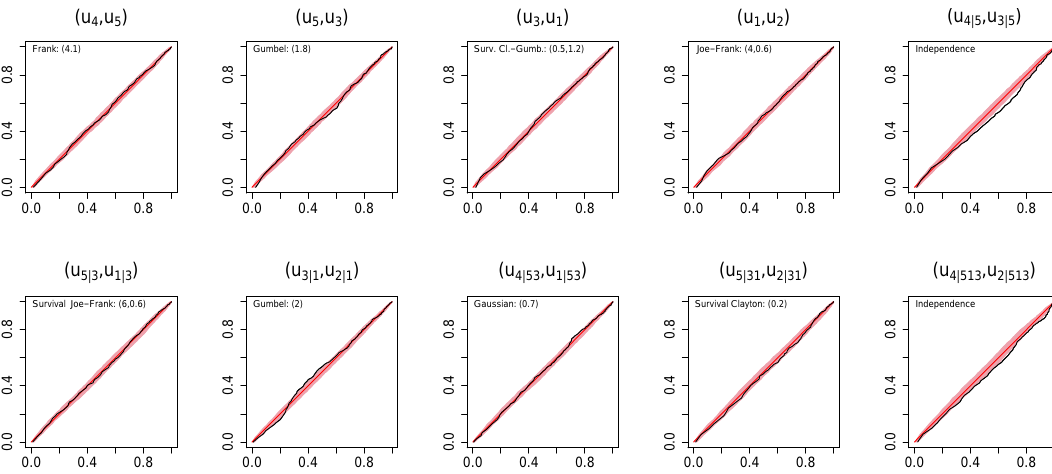
Figure C1. K-plots of the pair-copula families selected for the five-dimensional model (names of the families and parameters are shown in the top left of each plot). In abscissa the empirical K-function and in ordinate the K-function based on fitted copula. The 95% confidence interval (shown in light red) is obtained from 10 4 K-plots computed on simulated pairs (with the same length as the observed data) from the selected pair-copula